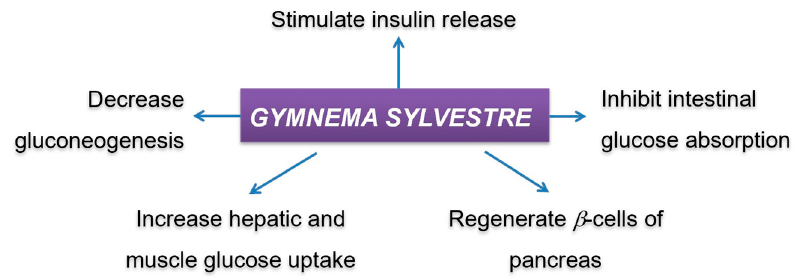
Figure 12. Mechanisms of Gymnema sylvestre in the antidiabetic activity.